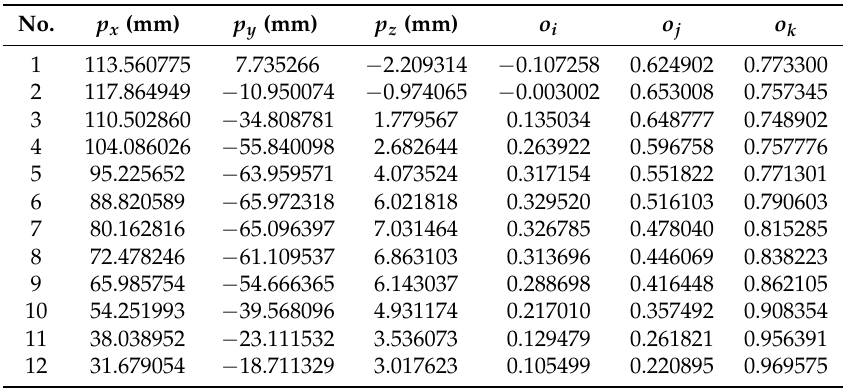
Table A1. Experimental cutter location